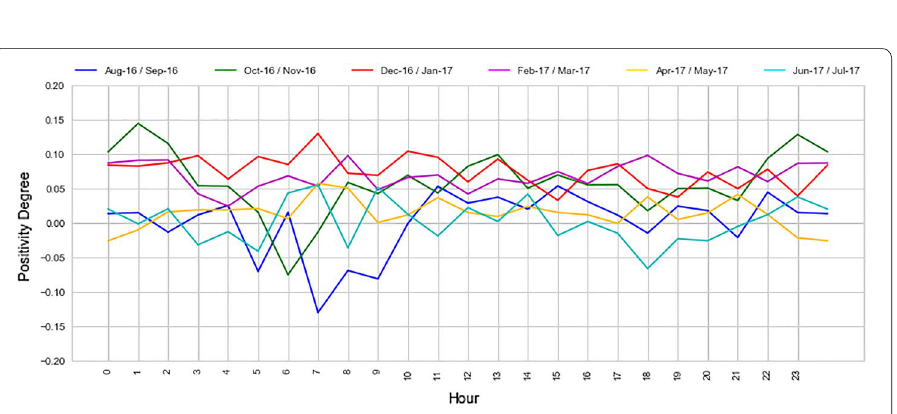
positive and negative sentiment, particularly observed at 7 a.m. in the months of Aug- 16/Sept-16 and Dec-16/Jan-16.